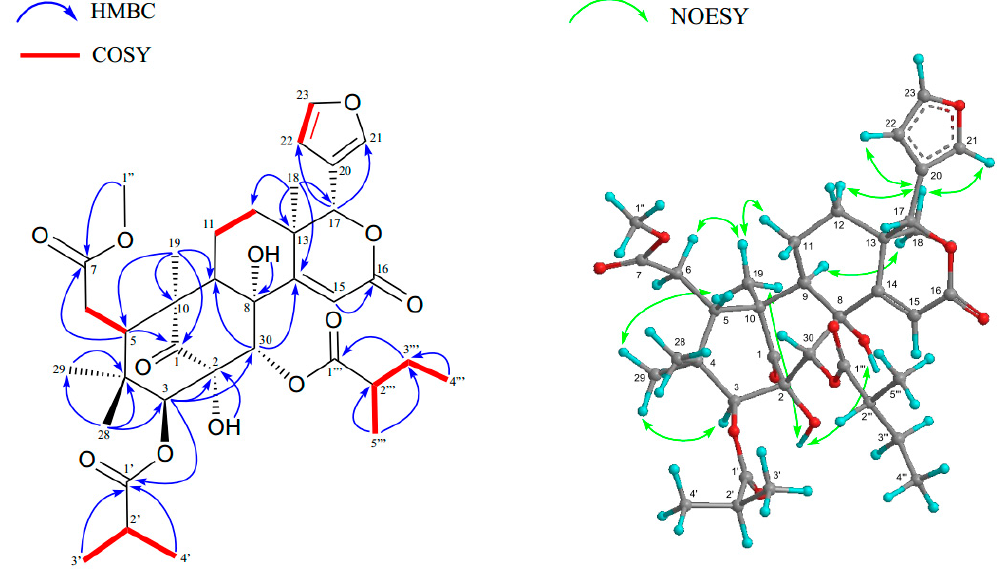
Figure 3. Key HMBC, COSY, and NOESY correlations of Carapanosin E ( 2 ). Table 2. 1 H and 13 C ‐ NMR spectroscopic data of compounds 2 and 3 (600 MHz, CDCl 3 , 150 MHz).